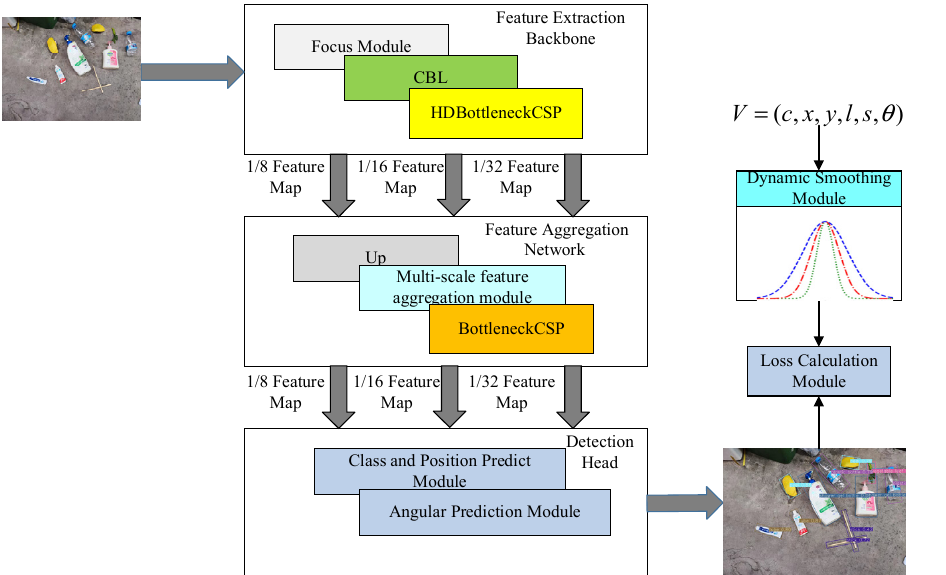
Figure 2. Rotation angle waste detection scheme.